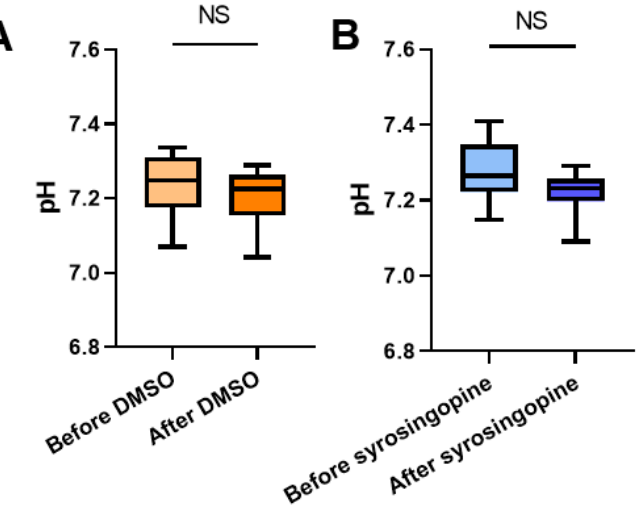
Figure 6. Impact of syrosingopine on tumor pHe. Evolution of pHe (estimated using CEST-MRI) in MDA-MB-231 tumors in mice before and after 4 days of treatment with DMSO (control, ( A )) or syrosingopine ( B ). Data are represented as mean ± SEM. Significance was determined using Paired t -test; n = 10 in both groups. NS = not